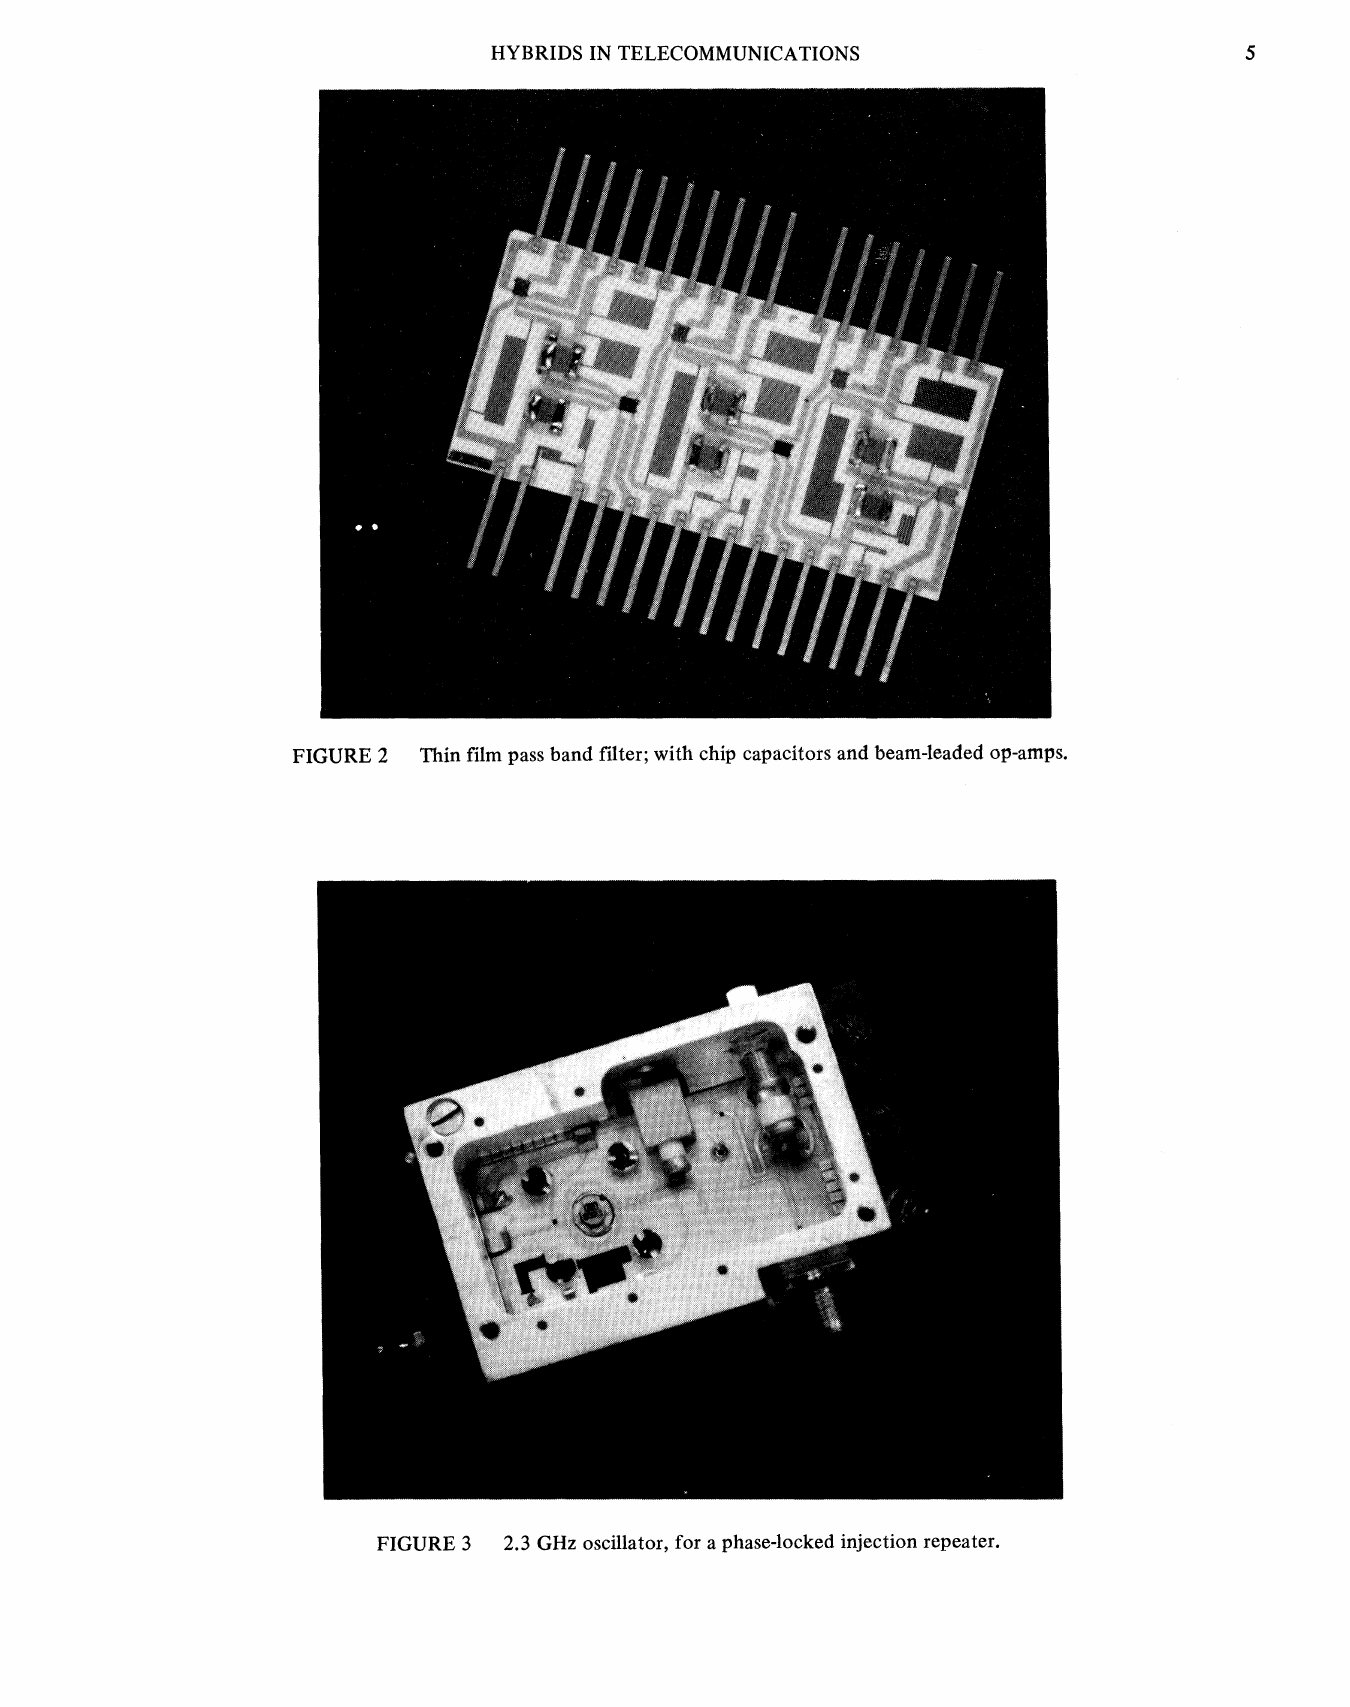
FIGURE 3 2.3 GHz oscillator, for a phase-locked injection